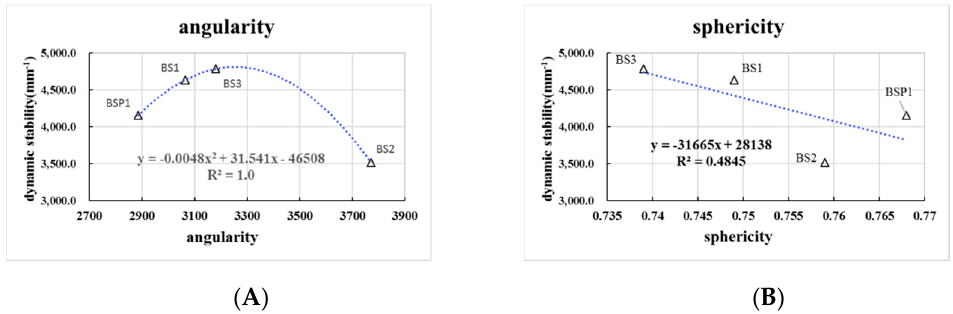
Figure 13. Correlation between rutting test results and aggregate geometric characteristics. ( A ) correlation between dynamic stability and angularity; ( B ) correlation between dynamic stability and sphericity.